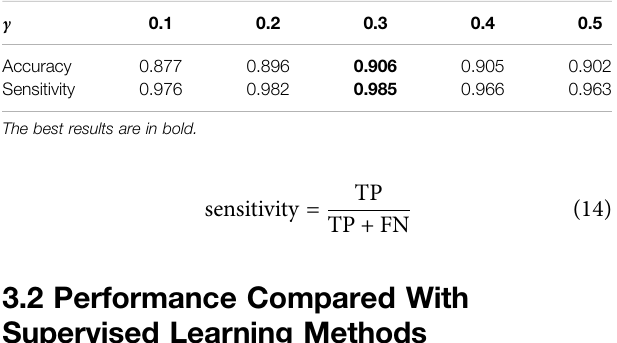
TABLE 5 | DR classi fi cation results using different γ on the APTOS 2019 dataset.